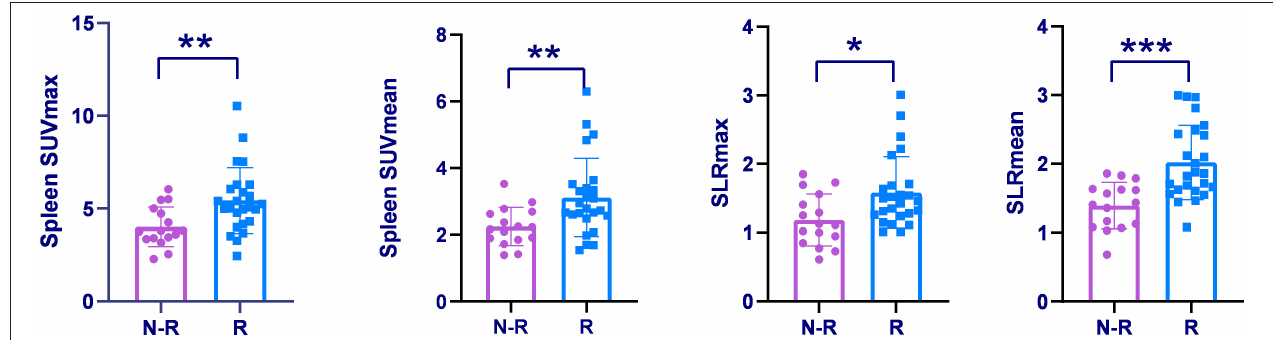
FIGURE 5 | Spleen SUVmax, Spleen SUVmean, and SLRs were compared among the recurrence group and non-recurrence group. * P < 0.05, ** P < 0.01, *** P < 0.001.